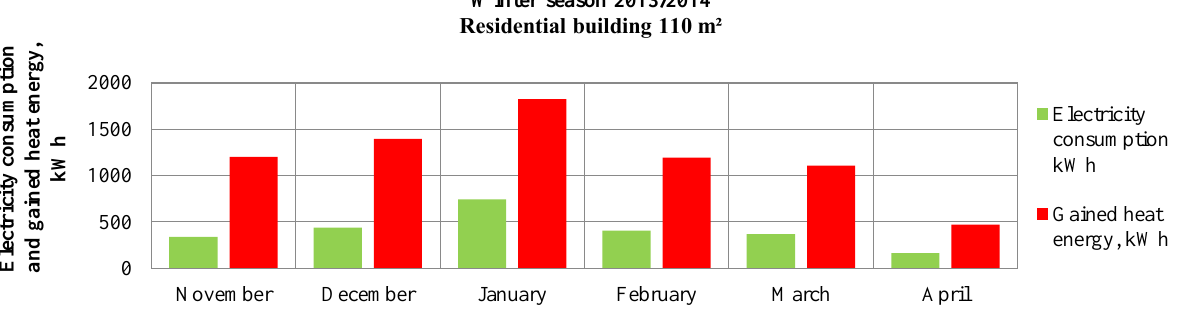
Fig. 4. Gained heat energy and electrical energy consumption results for the example residential building of 110 m 2 in season 2013/2014.